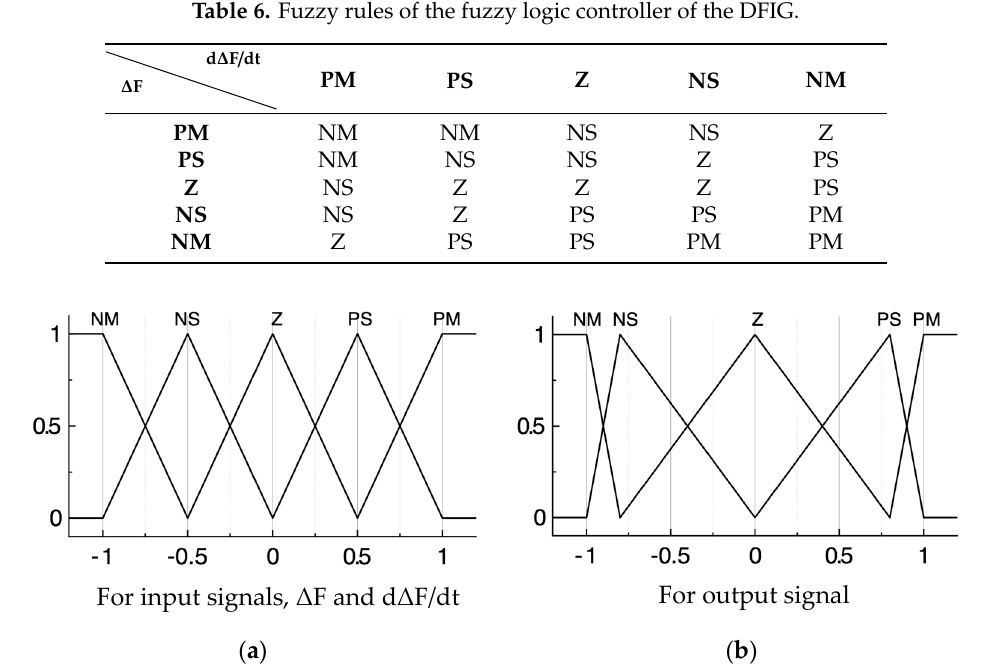
Figure 8. Membership function of the fuzzy logic controller of the DFIG. Table 6. Fuzzy rules of the fuzzy logic controller of the DFIG.